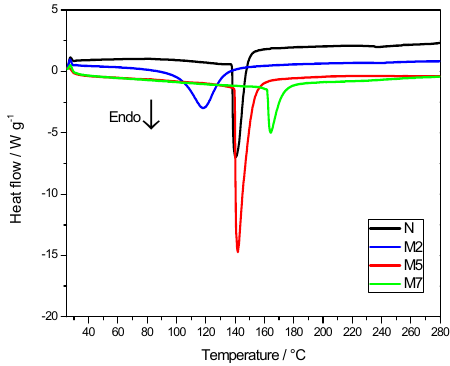
Figure 3. Di ff erential scanning calorimetry (DSC) curves of the membranes. Figure 3. Differential scanning calorimetry (DSC) curves of the membranes. Table 2. Δ H and the T onset associated to the DSC thermal transition of the polymer ionic clusters in the membranes (see Figure 4).